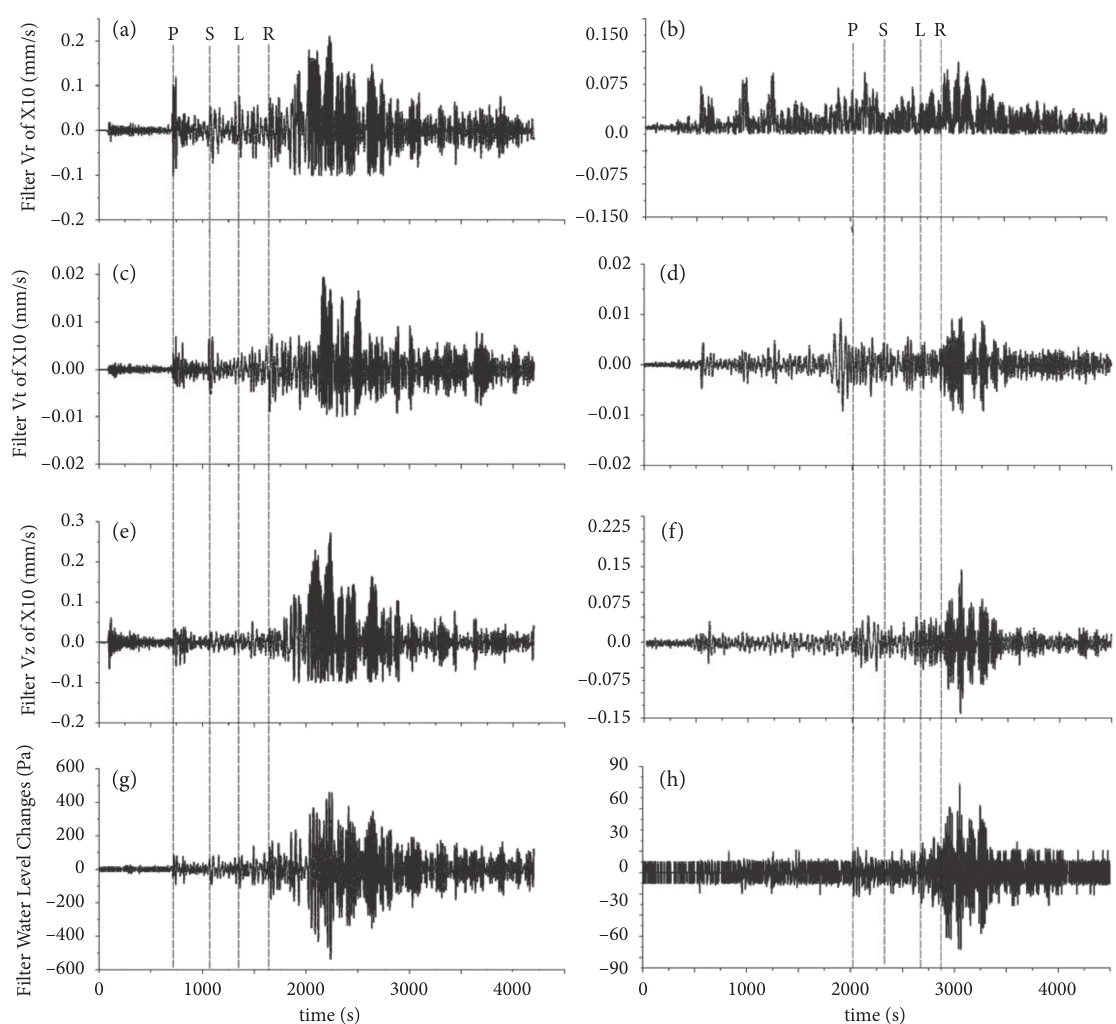
Figure 2: Comparison of hydroseismograms and three-component seismograms from 1: 50 to 3: 05 (GMT +8:00) on 9 December 2016 of the M w7.8 Solomon Islands earthquake and from 18:43 to 19:58 (GMT +8:00) on 13 November 2016 of the (M)w7.8 Kaik � oura earthquake. (a, b) Radial seismograms. (c, d) Transversal seismograms. (e, f) Vertical seismograms. (g, h) Water level changes. Annotation marks the arrivals of P, S, L, and R waves.